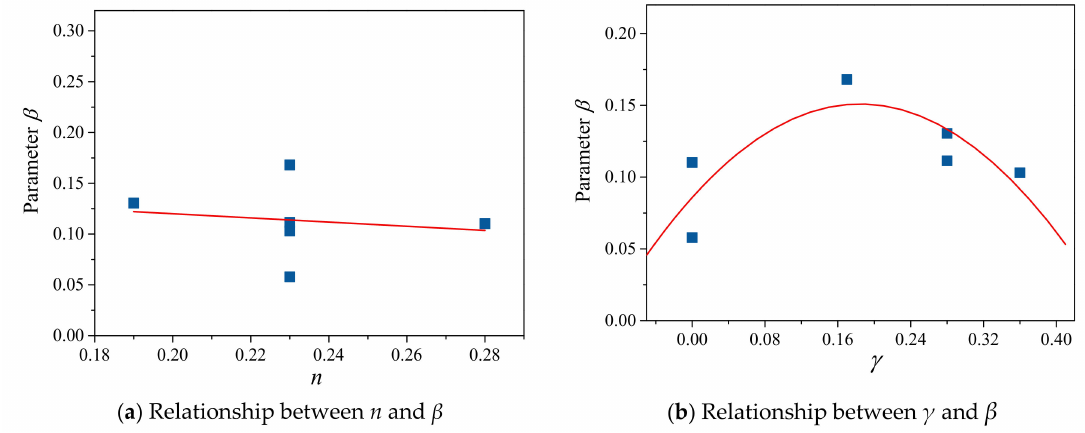
Figure 14. Relationship curves of flexural damage parameter β .